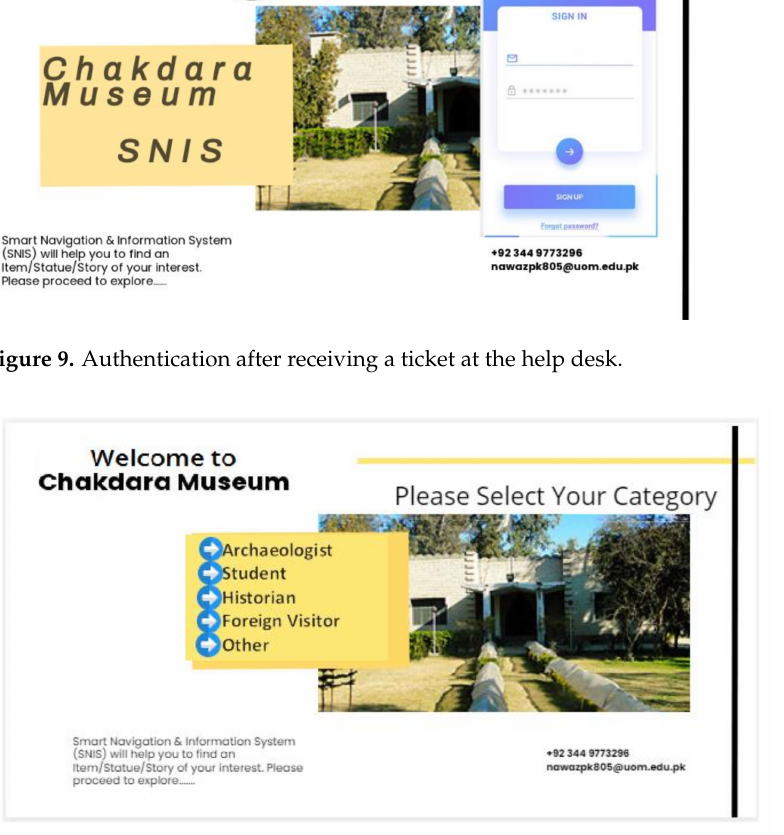
Figure 10. User profile